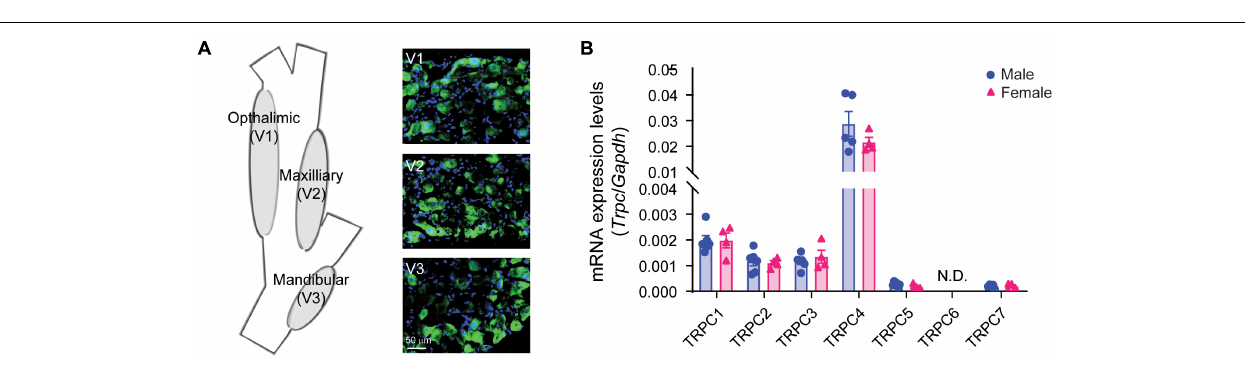
FIGURE 2 | Characterization of TRPC4 expression in trigeminal ganglia (TG) tissue. (A) Illustration of the TG and its three branches (V1–V3) innervating the head and face, and TRPC4 immunofluorescence (green) in the V1, V2, and V3 areas. DAPI (blue) was used as tissue counterstaining. (B) Transcriptional analysis of the TRPCs in TG tissues from male and female mice. GAPDH was used as the housekeeping gene. n = 4–6 mice/sex/group.